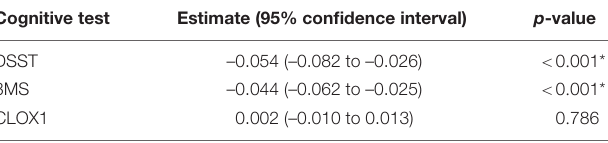
TABLE 2 | Univariable (unadjusted) linear mixed models.